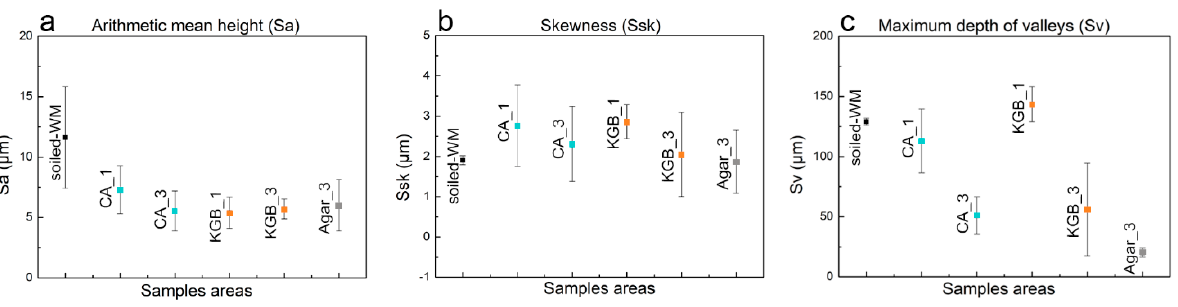
Figure 6. Considered roughness values of Sa ( a ), Ssk ( b ), and Sv ( c ) on the different areas of soiled − WM cleaned by different gels and application time CA_1, CA_3, KGB_1, KGB_3, and Agar_3.